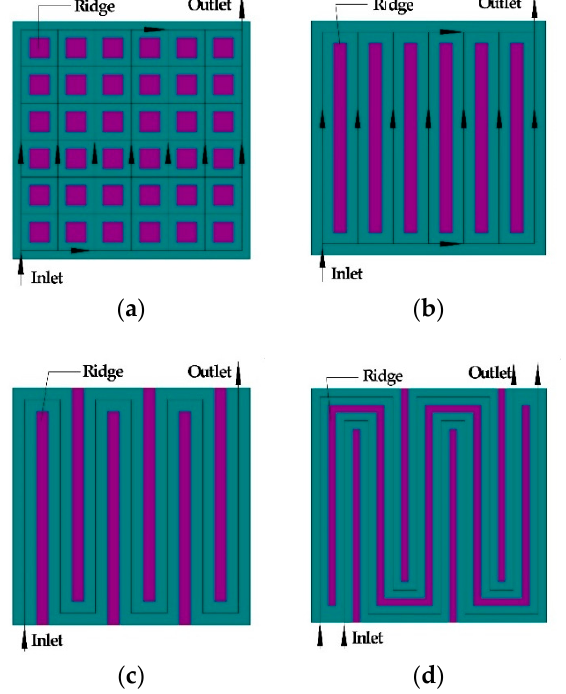
Figure 1. Design of the anode flow fields: ( a ) grid flow fields, ( b ) parallel flow fields, ( c ) single- serpentine flow fields, and ( d ) double-serpentine flow fields. Table 2. Geometric parameters of the single-serpentine flow fields with four open ratios.